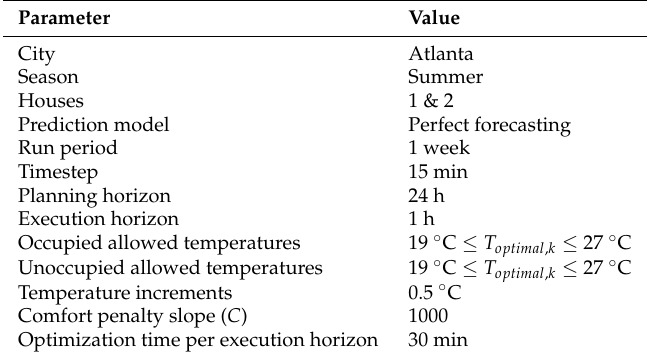
Table 15. Settings used for MPC optimization in Case 2B.